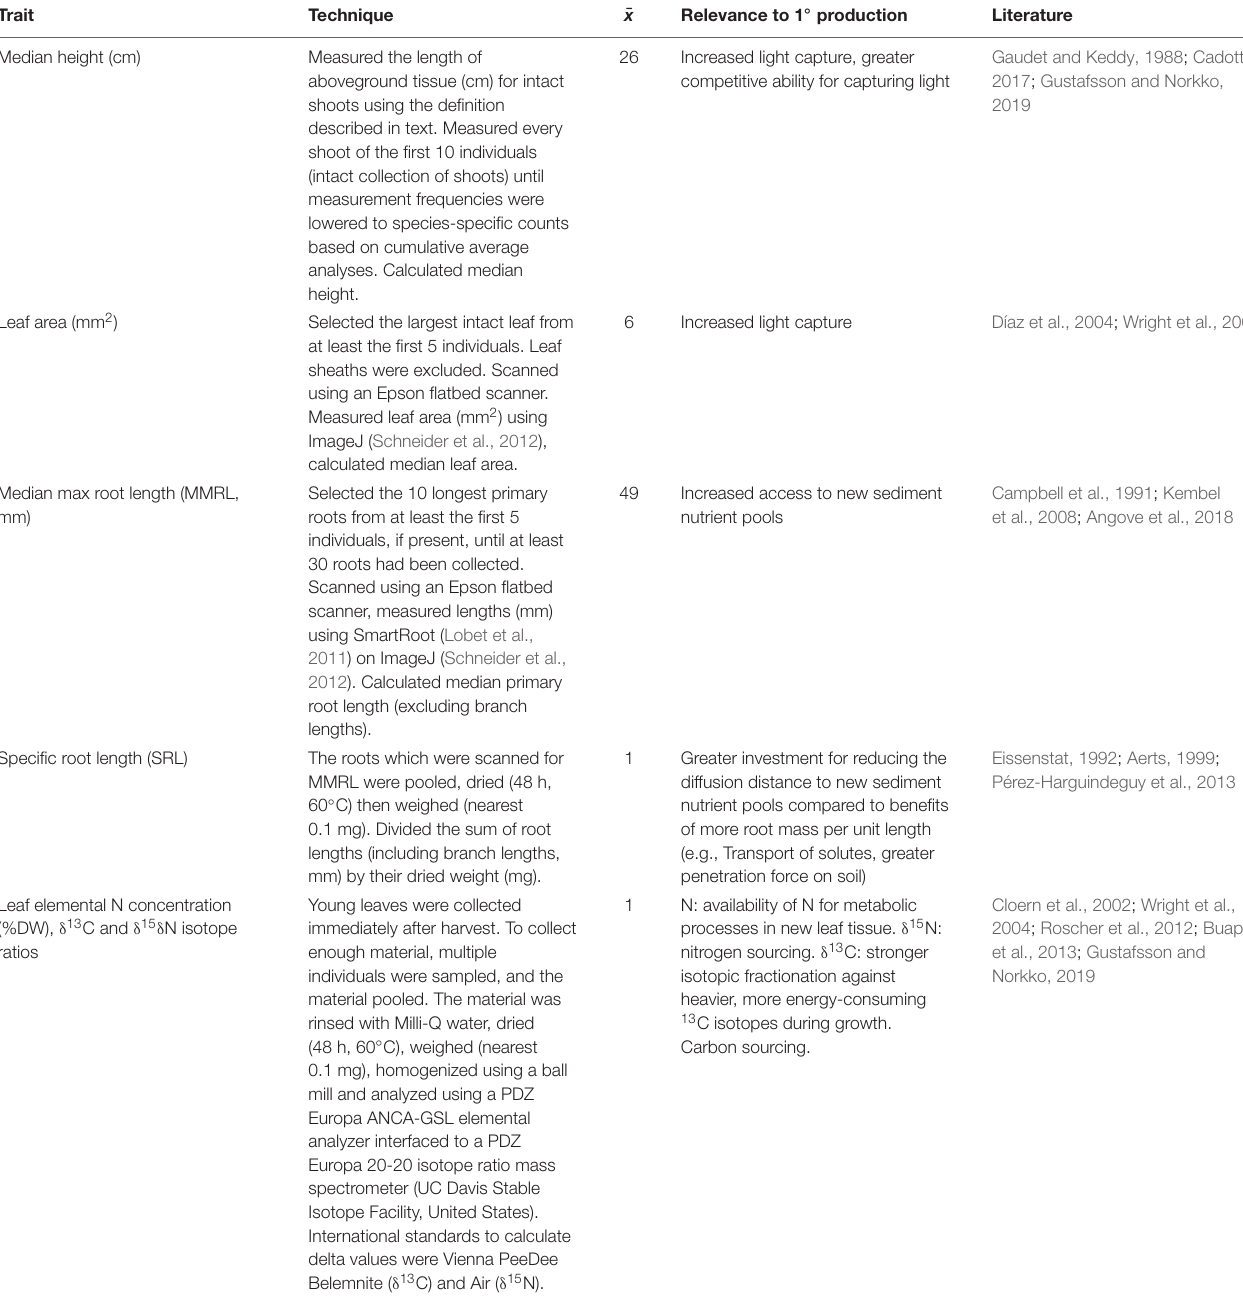
TABLE 1 | Description of the traits which were measured for each species in each community; their abbreviations, the technique used to quantify them, the average frequency of measurements for each species trait value, the relevance of the trait to primary production in aquatic plant communities and the literature from which these relationships are